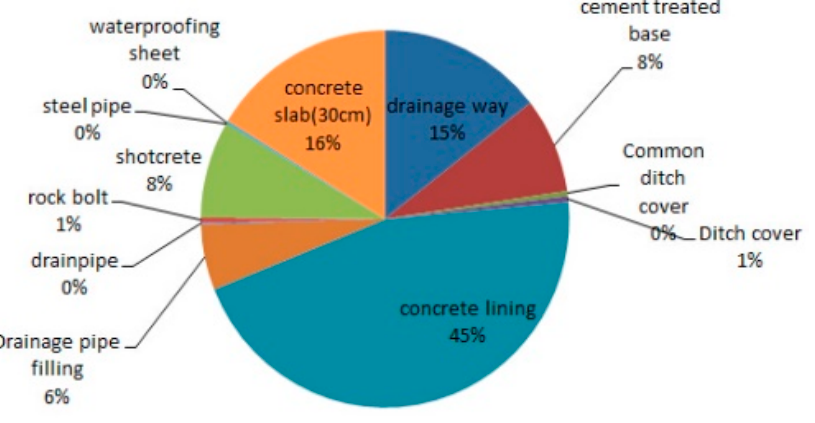
Figure 10. Proportion of quantity of each section in tunnel.